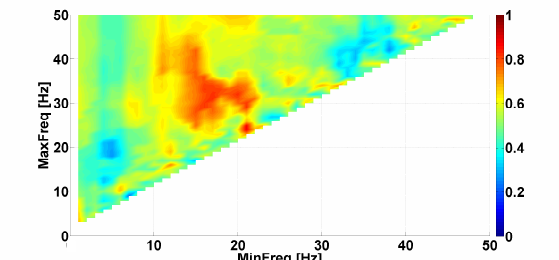
Figure 4. Example of Phase-difference AUC diagram. This AUC diagram is a kind of Frequency AUC diagram. PD and ET patients are compared, namely, right arms with hyperkinetic movements are analyzed. The abscissa axis is the lower bound of the frequency range; the ordinate axis is the upper bound of the frequency